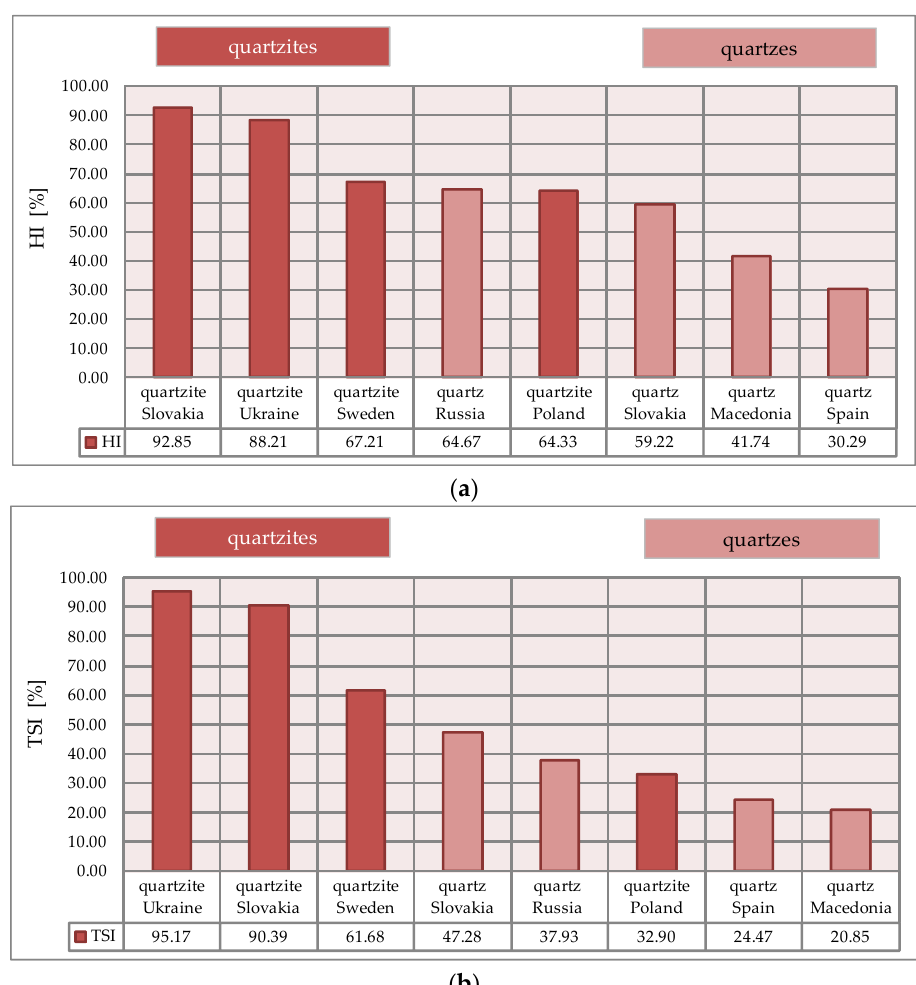
Figure 9. Calculated indexes HI ( a ) and TSI ( b ) for samples at 1600 °C.